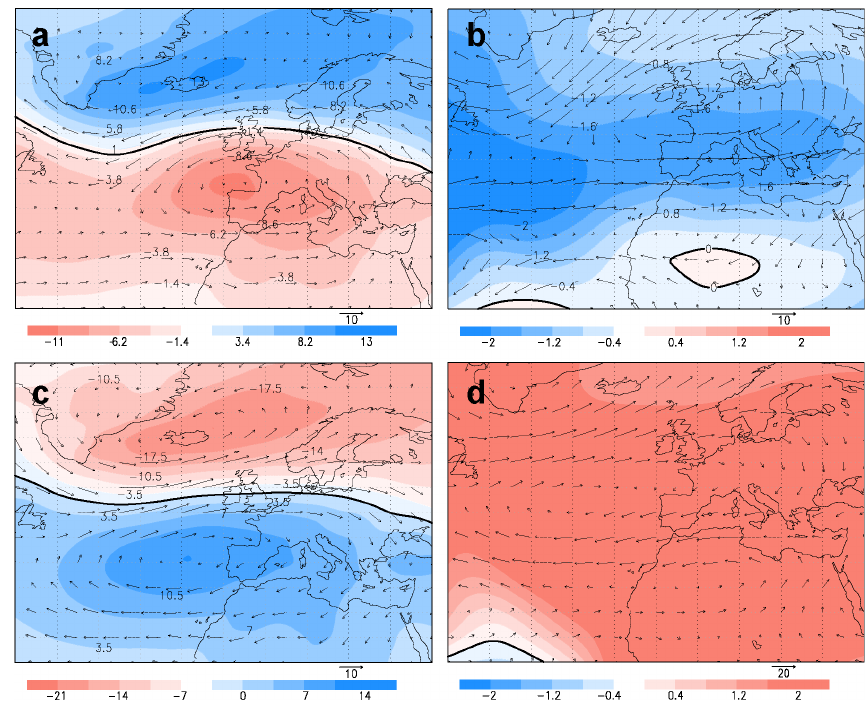
Fig. 4. Composite maps of SLP (hPa) and wind (ms − 1 ) at 850hPa (a) and velocity potential ( × 10 6 m 2 s − 1 ) at 200hPa (b) for extreme CWD (PC1) in winter. Same maps for the NAO ( c and d